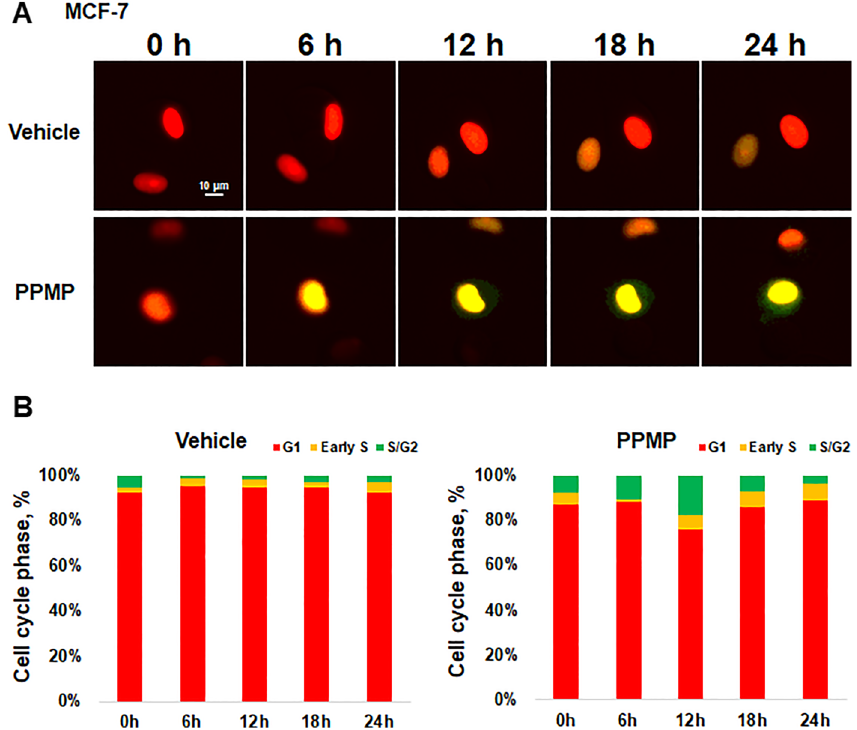
Figure 5. Effect of PPMP on cell cycle in breast cancer cells. ( A ) FUCCI images were captured after the PPMP application at 0, 6, 12 and 24 hours while monitoring the cell cycle of living cells in real-time. The scale bar represents 10 µm. ( B ) Histograms show the cell cycle rate at each time. Cells at each cycle stage were quantitatively evaluated by counting the number of cells of each color. Cell cycle profiles are color coded: G1, red; initial S, yellow; and late S/G2/M, green (n = 52–129 per group total number of